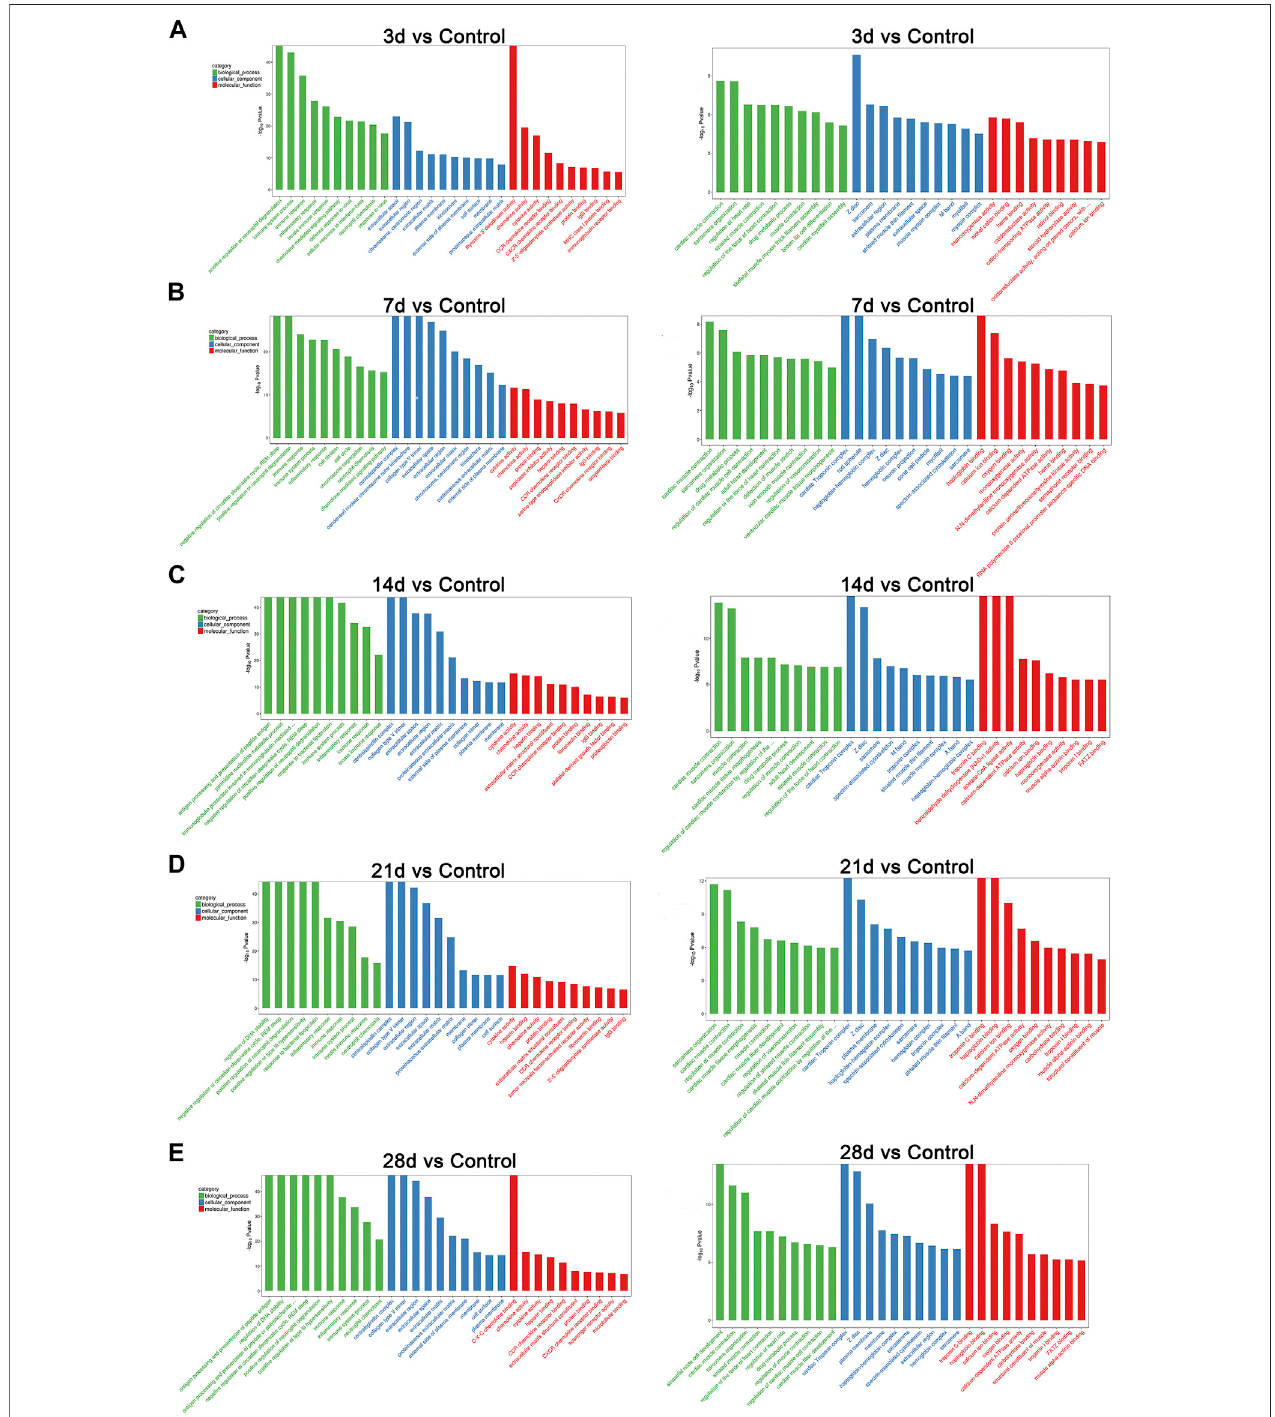
FIGURE 2 | GO analysis of differentially expressed genes at different stages of post-bleomycin mice. The top 30 GO annotations of differentially expressed genes between the group of mice treated with bleomycin and the control are shown. (A) Third day post-bleomycin vs. the control. (B) Seventh day post-bleomycin vs. the control. (C) Fourteenth day post-bleomycin vs. the control. (D) Twenty- fi rst day post-bleomycin vs. the control. (E) Twenty-eighth day post-bleomycin vs. the control. (A – E) GO analysis describing the possible functions of differentially expressed genes through the biological process, cellular component, and molecular function categories. Green indicates the biological process, blue indicates the cellular component, and red indicates the molecular function. Left panel, upregulation; right panel, downregulation.